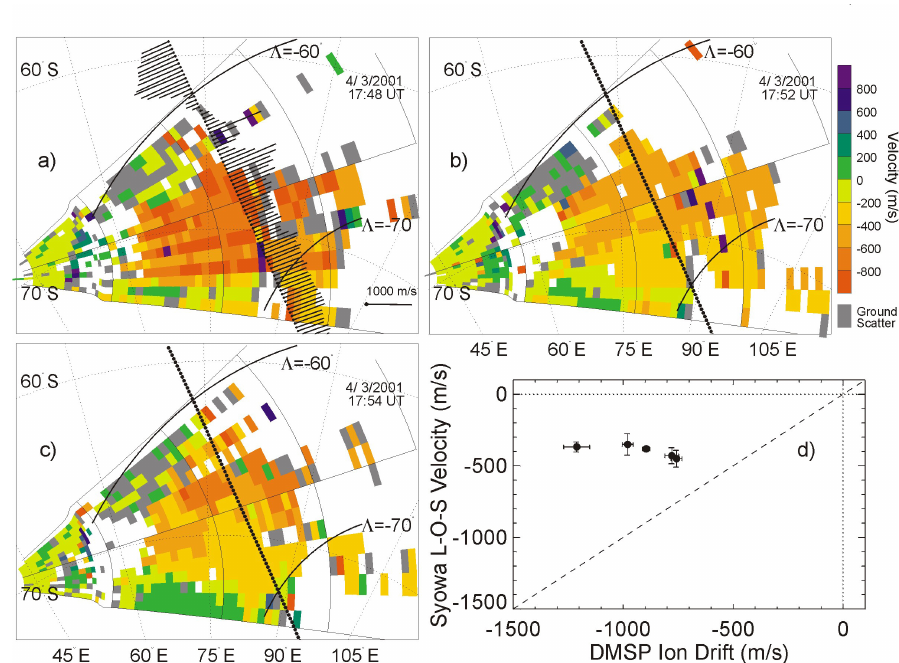
Fig. 7. (a) − (c) Syowa-East l-o-s velocity maps for 17:48, 17:52 and 17:54 UT and the DMSP cross-track ion drift observed between ∼ 17:49 and 17:53 UT for the event of 4 March 2001. Panel (d) is a scatter plot of the radar velocity versus DMSP ion drift for the points in panel (b) with the difference between the radar and satellite directions of less than 5 ◦ and the difference in time of less than